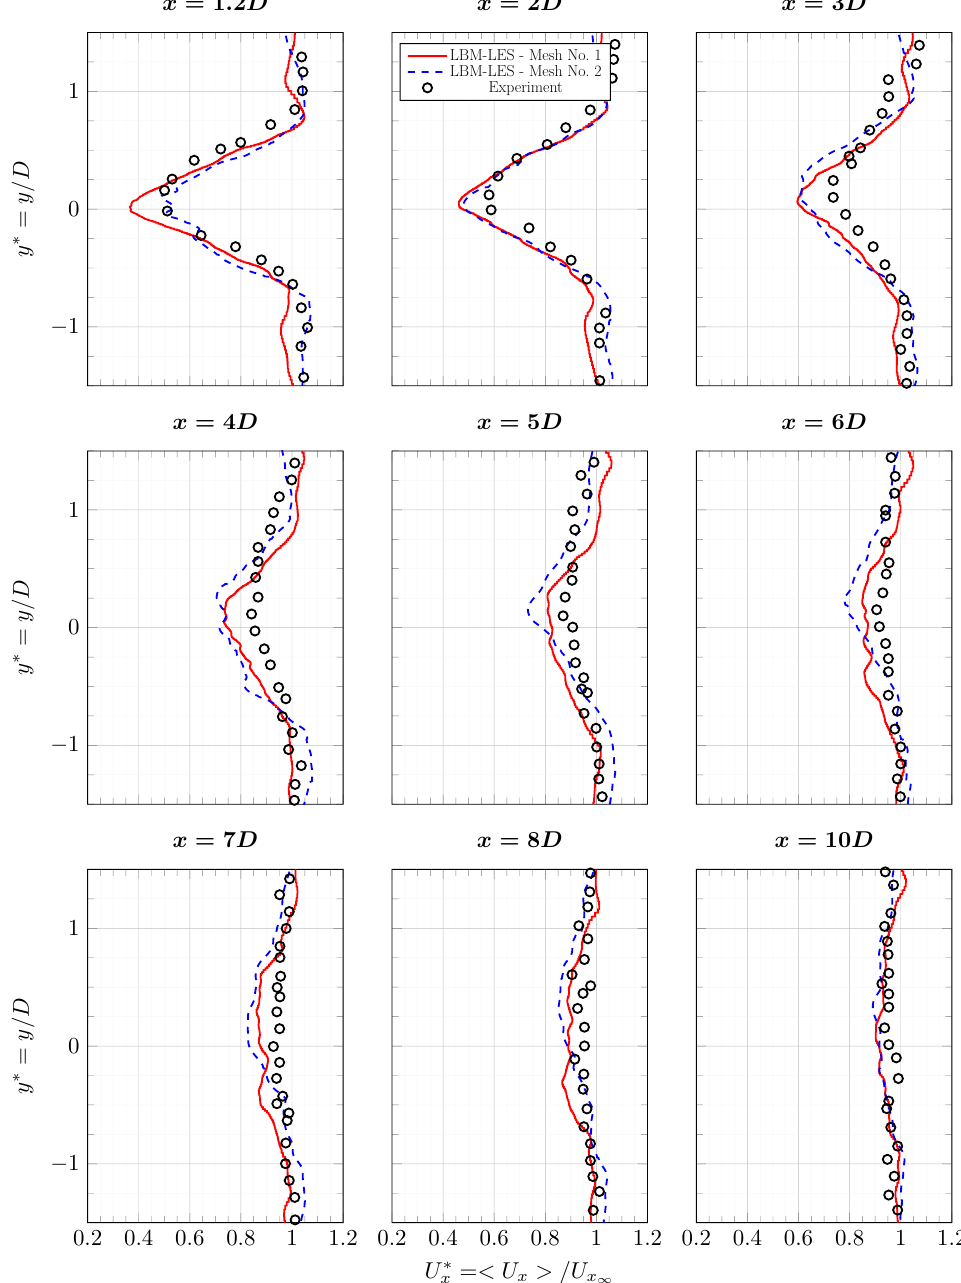
Figure A3. Average axial velocity profiles in the wake of the tidal turbine at TSR = 3.67 and I = 12.5%. Results are from experiment [6] and from LBM-LES simulations with mesh Nos. 1 and 2. Complete profile